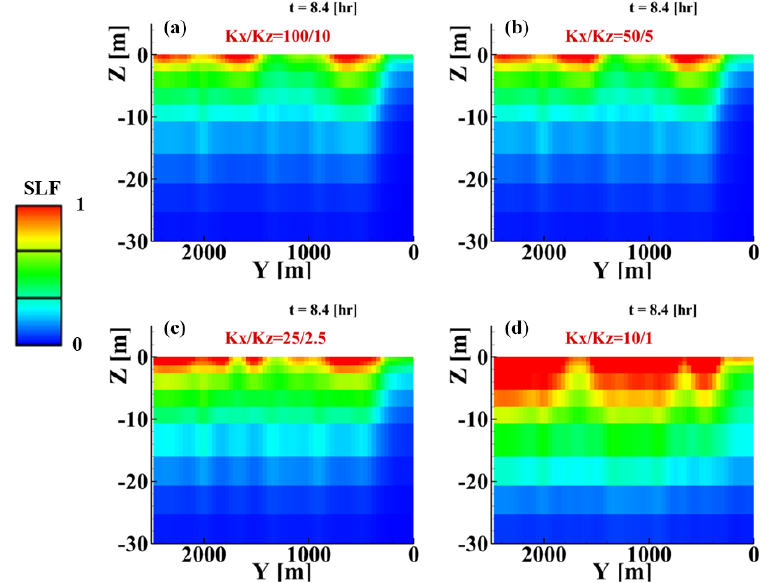
Figure A4. Contours (color scale on the left) of peak SLF ( t = 8 . 4h) vertical slices at the shoreline ( X = 450m) for K x and K z of (a) 100 and 10, (b) 50 and 5, (c) 25 and 2.5, and (d) 10 and 1md − 1